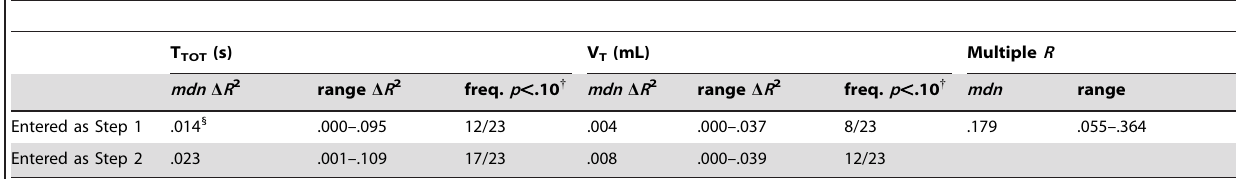
Table 4. Within-individual association of infant RSA with respiratory parameters T TOT entered in Step 1 and V T entered in Step 2, or in reverse order, calculated across all episodes of the Still-Face